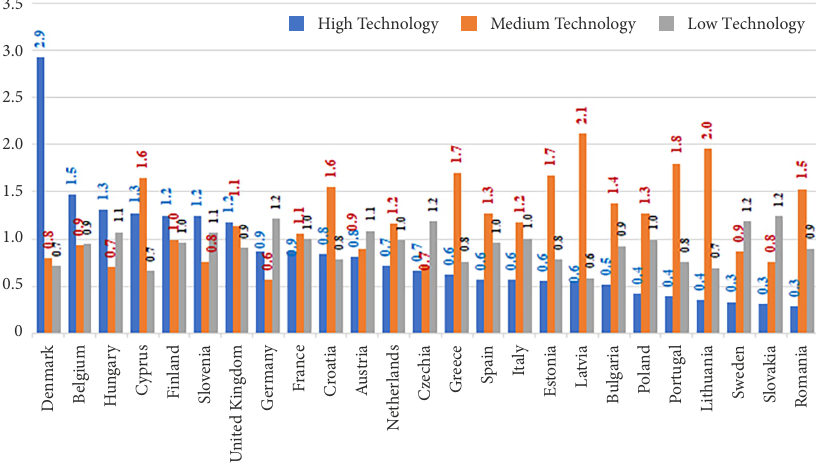
Figure 3. Industrial relative specialization index, 2018 (source: author computation based on Eurostat,